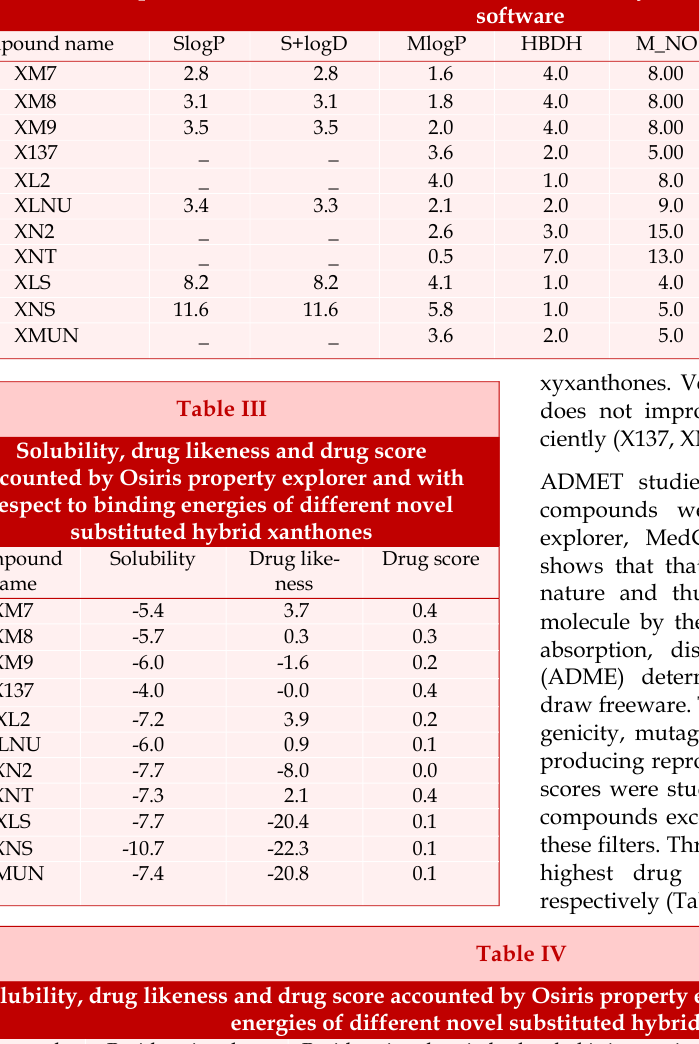
Molecular descriptors calculated for different novel substituted hybrid xanthones using MedChem designer